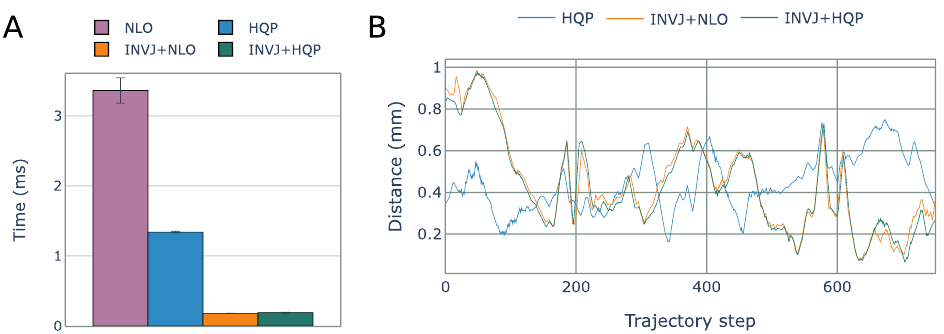
Figure 11. ( A ) Average IK solving time for the endoscope positioning task. ( B ) RCM error for each IK solver obtained from motion capture for each step of the helix trajectory.